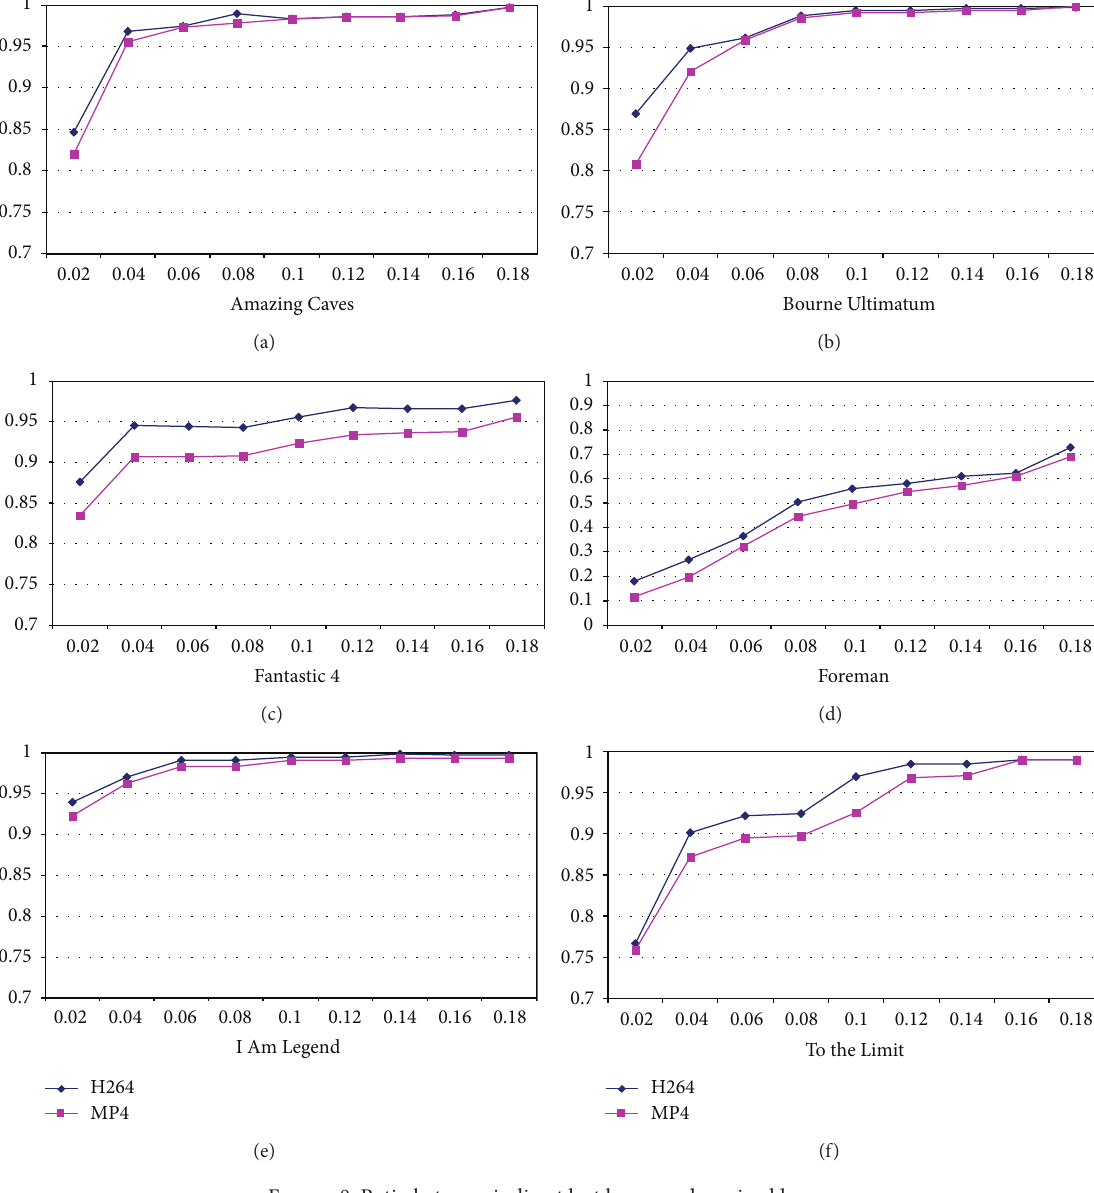
Figure 8: Ratio between indirect lost layers and received